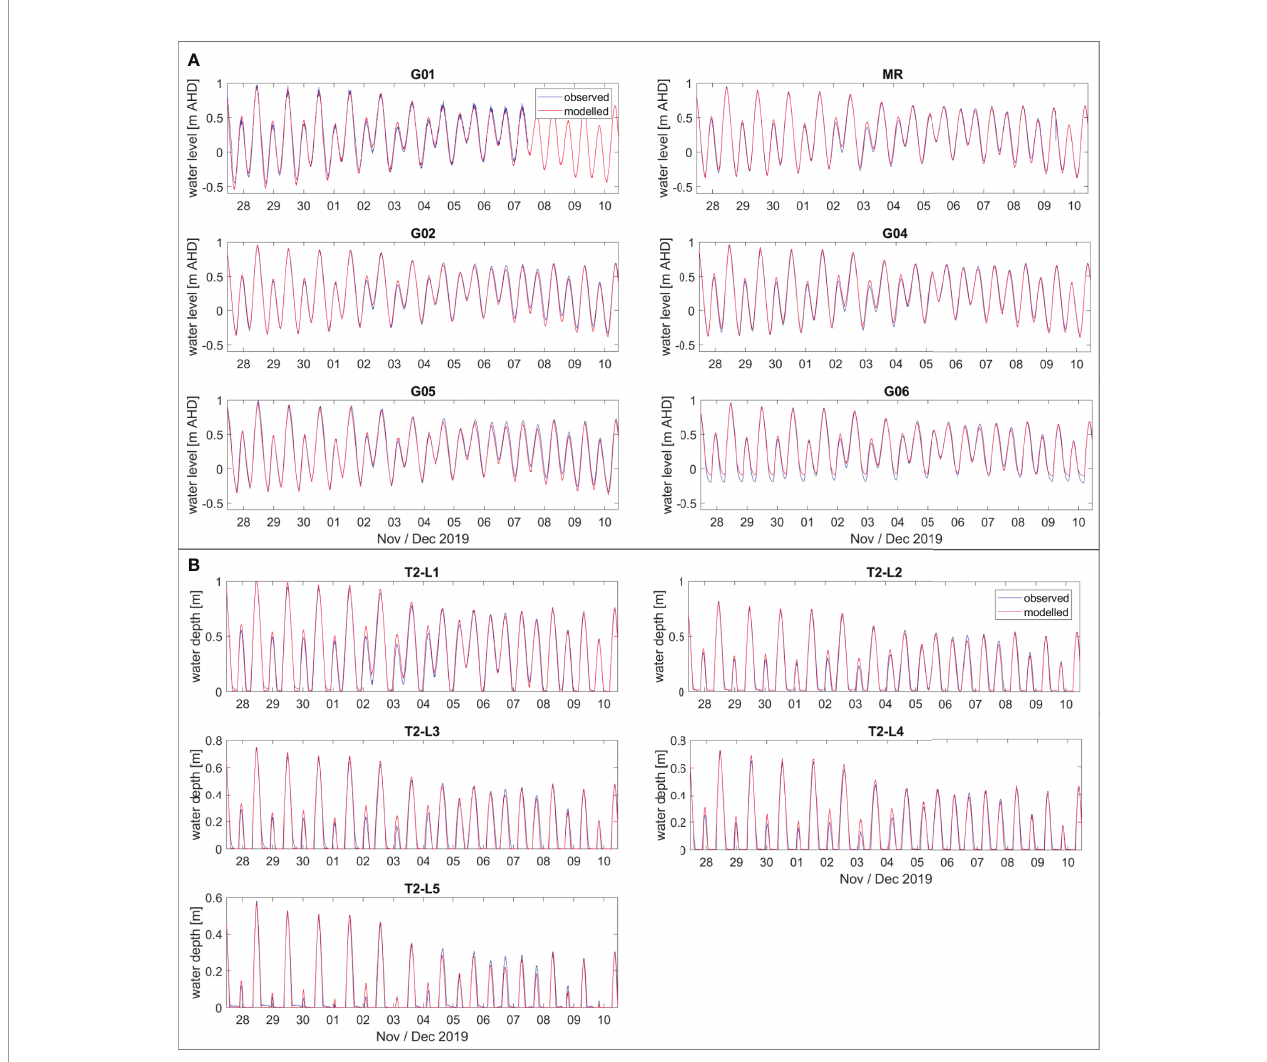
FIGURE 5 | Observed and modelled tidal water levels (A) and water depths (B) between 27 November and 10 December 2019 for monitoring locations at the Minnamurra River estuary.